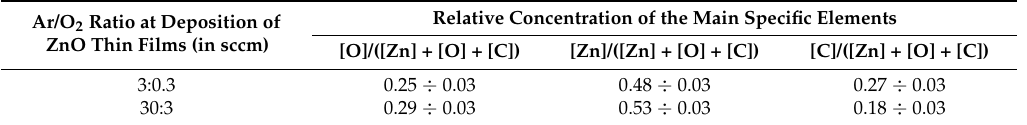
Table 1. The relative concentrations of all the main specific elements of nanostructured ZnO thin films in the subsurface layers. Relative Concentration of the Main Specific Ar/O 2 Ratio at Deposition of ZnO Thin Films (in sccm)